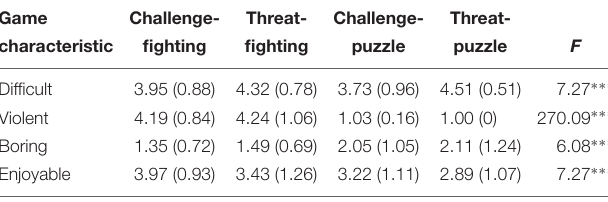
TABLE 3 | Means (SD) of game characteristic ratings across study groups.